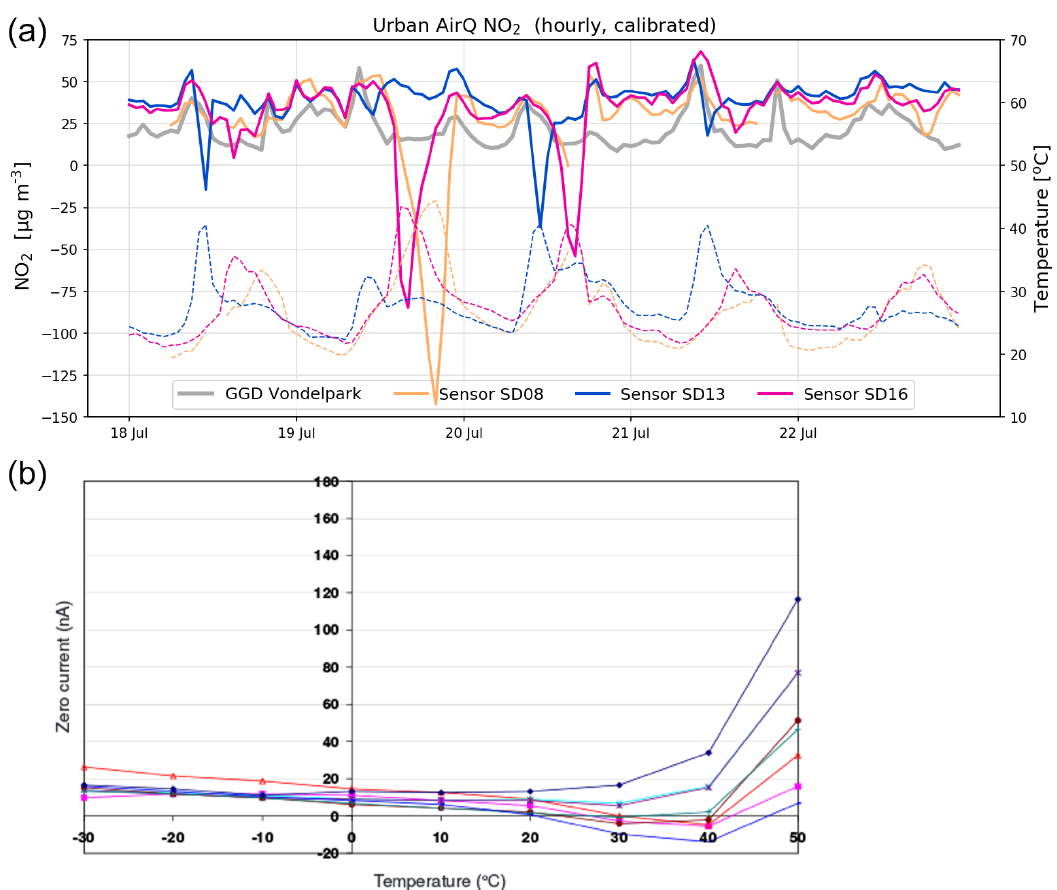
Figure 7. (a) Examples of negative spikes in the calibrated NO 2 measurements (solid line) due to internal sensor temperatures (dotted line) exceeding 30 ◦ C. (b) Variation of zero output of the working electrode caused by changes in temperature for a typical batch of electrochemical sensors. Image taken from Alphasense Data Sheet for NO2-B43F (Alphasense,